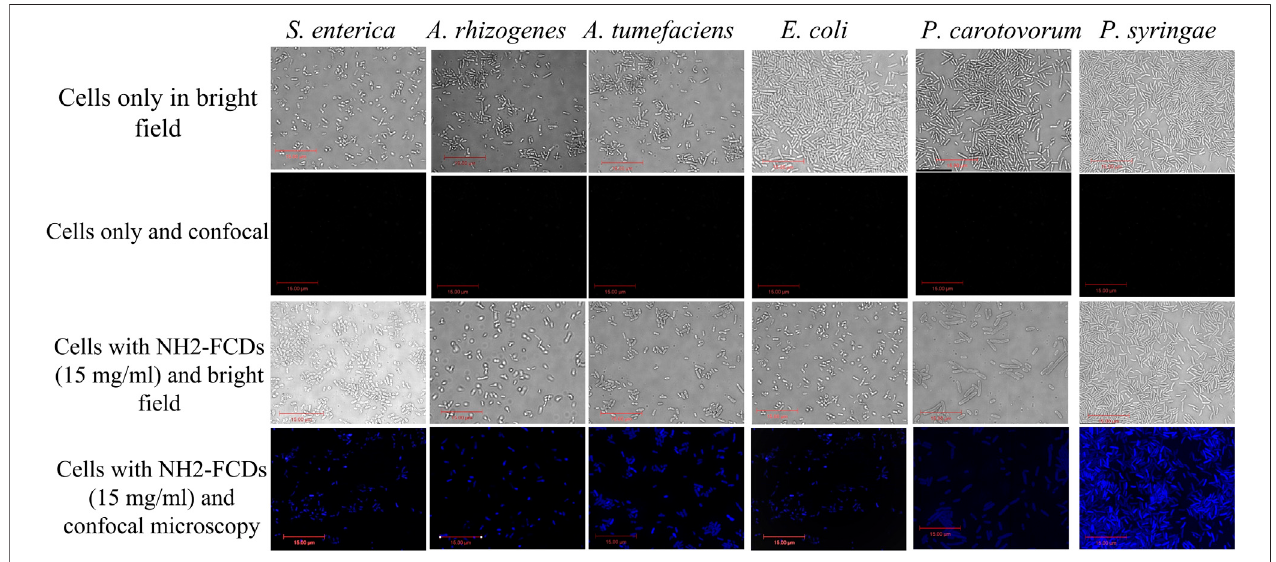
FIGURE 3 | Bacterial strains under DIC and confocal fl uorescence microscopy after 1 h incubation with NH2-FCDs (15 mg/ml) (Scale bar (cid:2) 15 um).